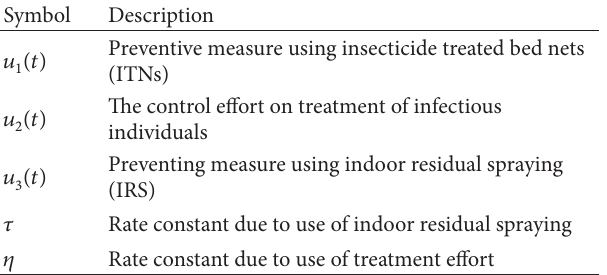
Table 2: Prevention and control variables in the model.